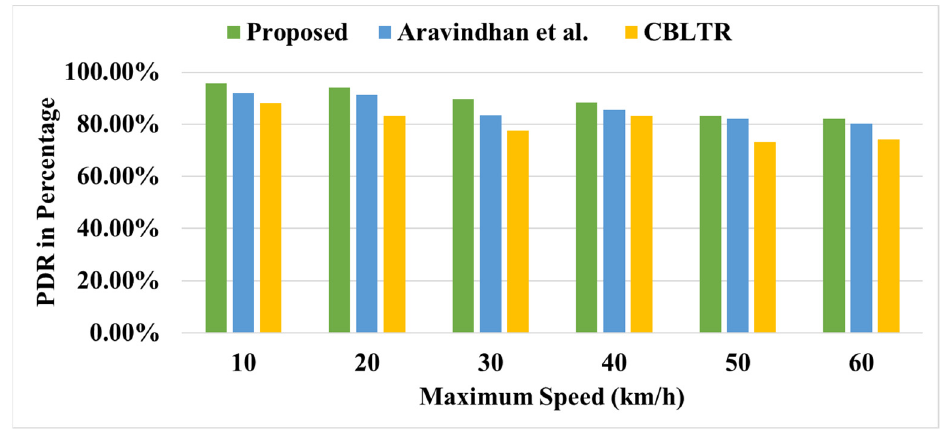
Figure 5. Comparison of results of the proposed system and existing systems (Aravindhan et al. [24] and CBLTR [21]) on PDR versus Mobility.